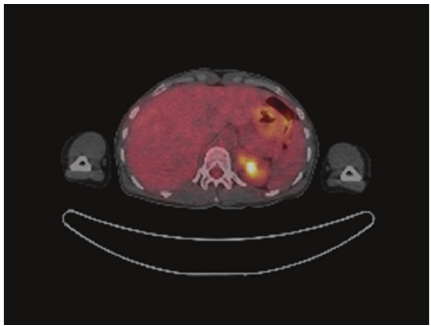
Figure 2: T1 hypointense liver lesion on MRI.